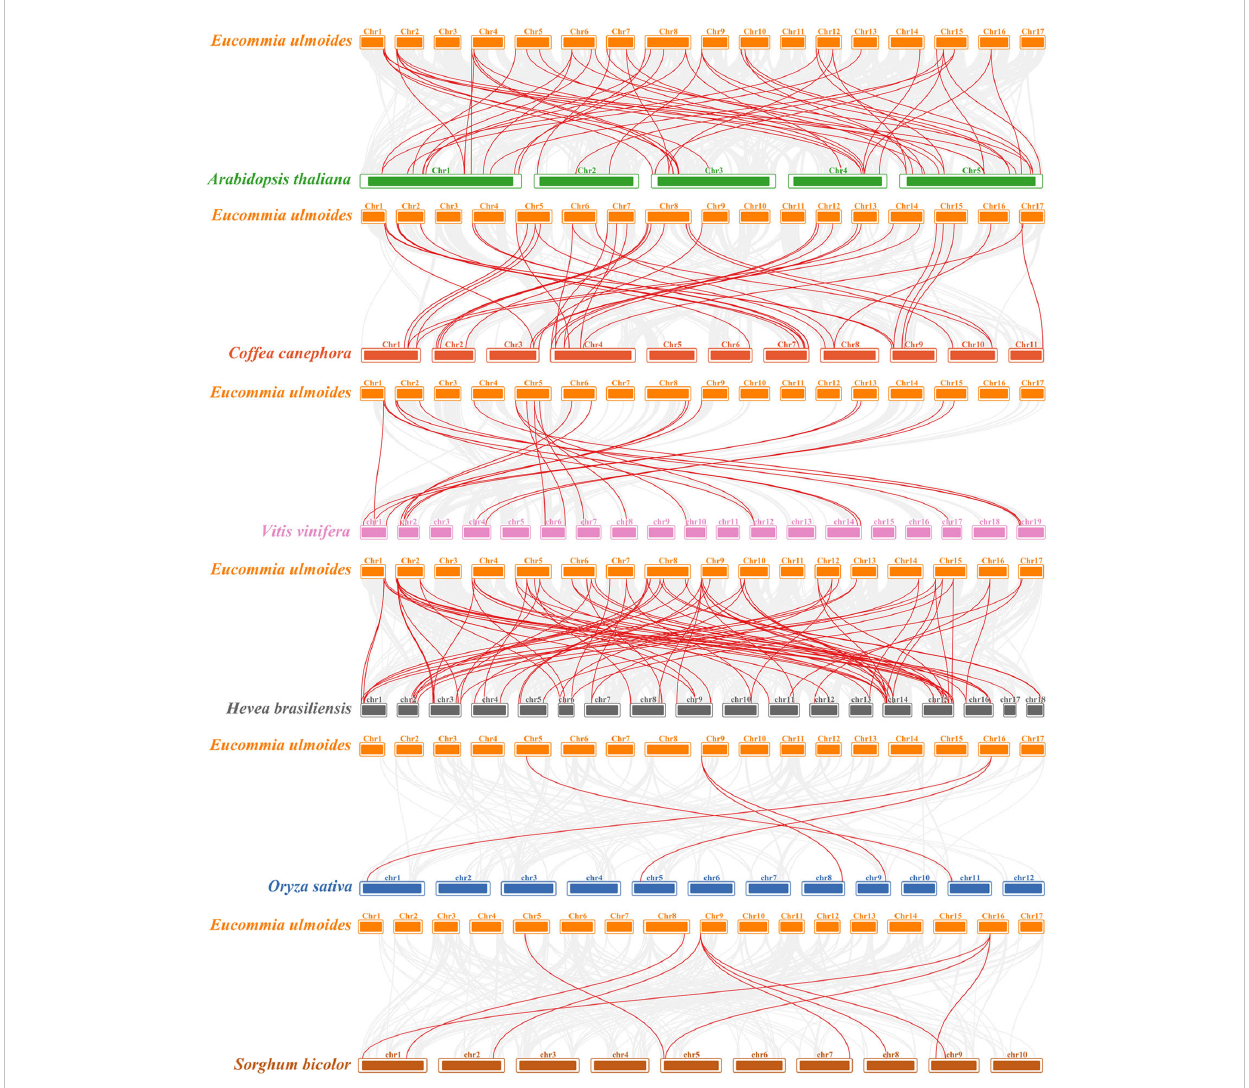
FIGURE 6 Synteny analysis of NAC genes between E. ulmoides and six representative plant species. Gray lines in the background indicate the collinear blocks within the E. ulmoides and other plant genomes, whereas the red lines highlight the syntenic NAC gene